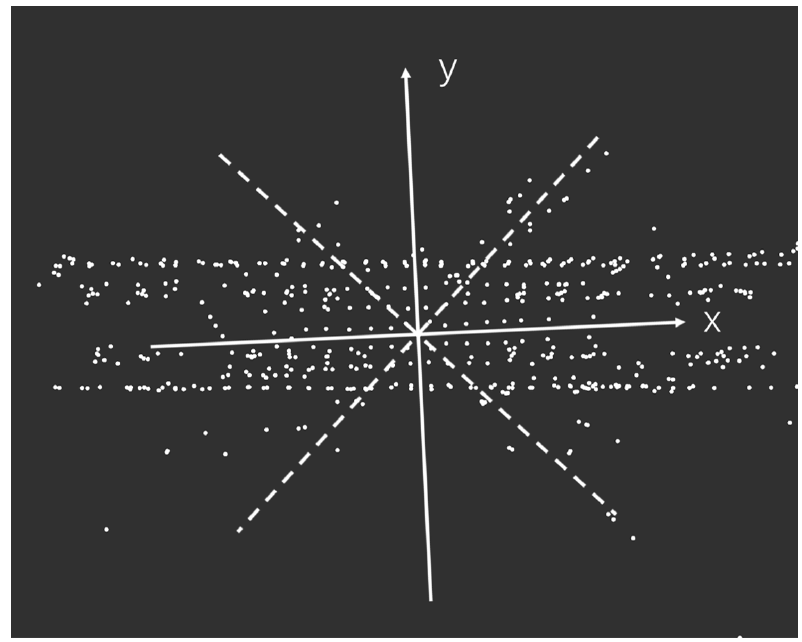
Figure 11. NDT valid matching points on the direct path.